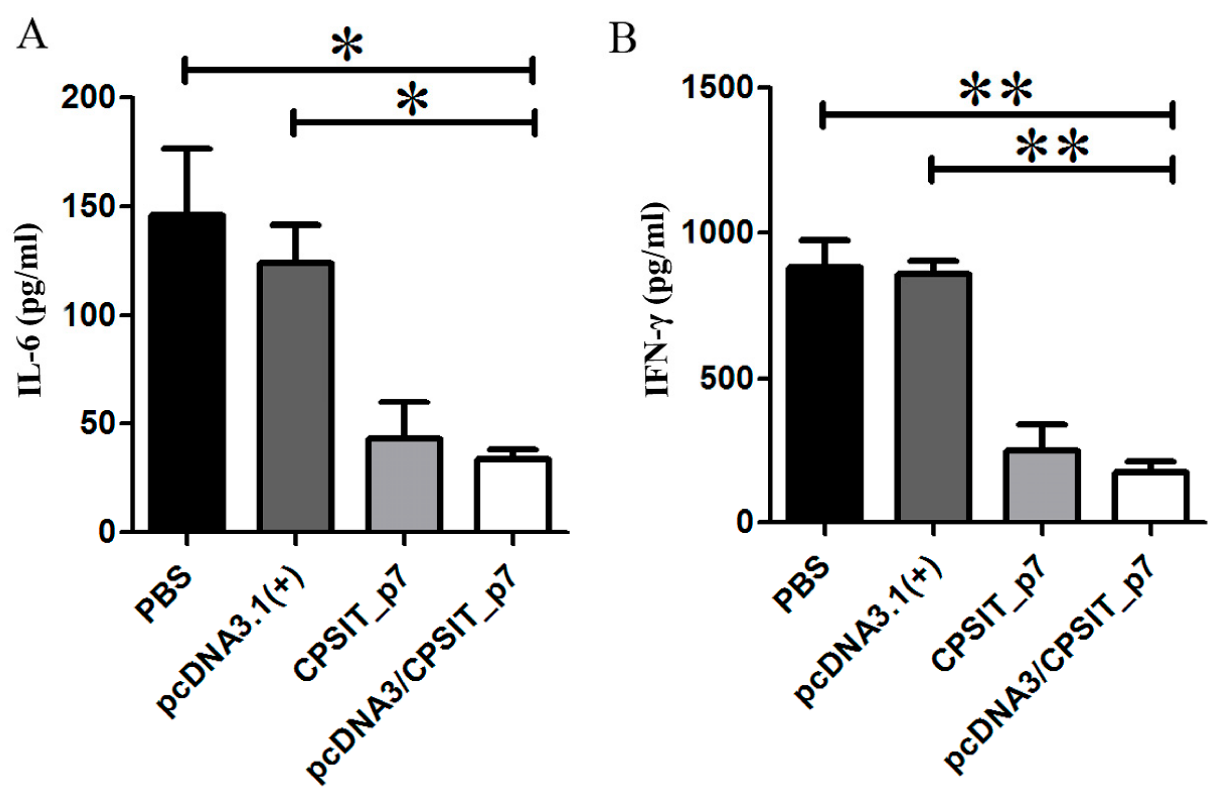
Figure 4. Cytokine levels in the lungs from C. psittaci -infected mice of each group. The supernatants of lung homogenates were collected 10 days after being challenged intranasally with 5 × 10 5 IFUs of C. psittaci . The production of IL-6 ( A ) and IFN- γ ( B ) in lung supernatants was detected by ELISA. Values shown are mean ± standard deviation from five mouse lungs in three independent experi- ments. * p < 0.05. ** p < 0.01.